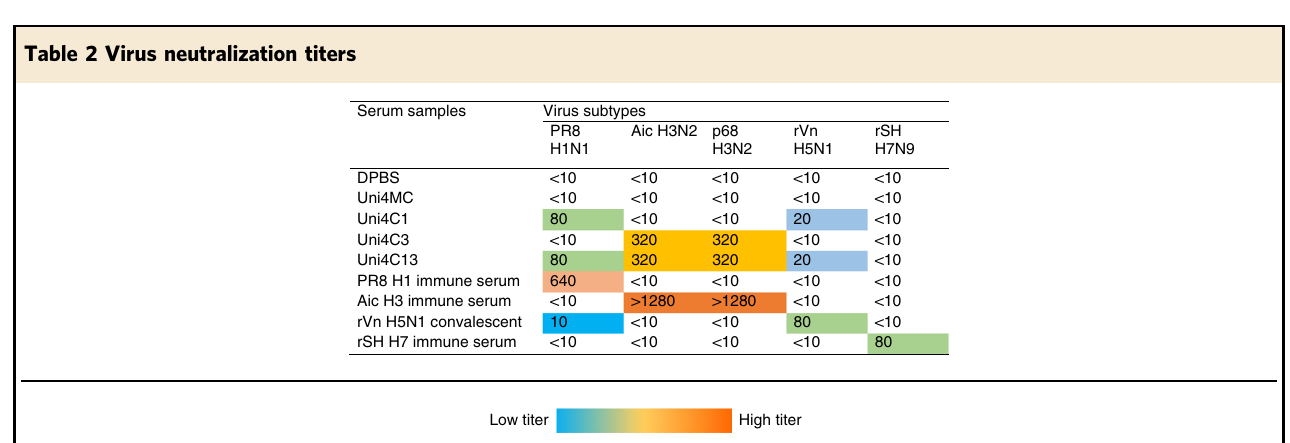
Table 2 Virus neutralization titers